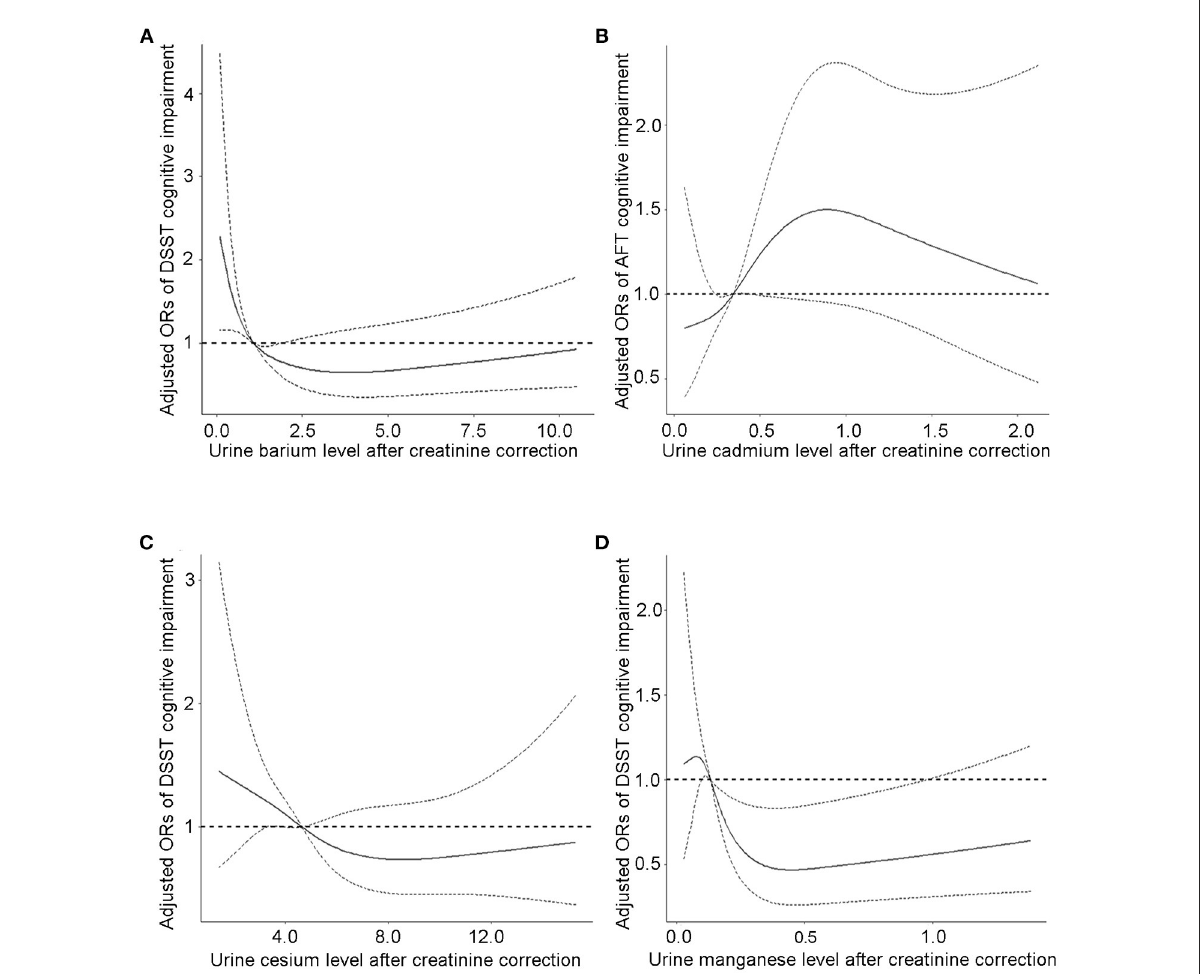
FIGURE2 The continuous relationship between urinary (A) barium levels, (C) cesium levels, (D) manganese levels and DSST cognitive test scores based on a restricted cubic spline regression model. The continuous relationship between (B) cadmium levels and AFT cognitive test scores based on a restricted cubic spline regression model. Adjusted for covariates (age, sex, educational level, BMI, and PIR). The solid lines represent the ORs, and dashed lines represent the 95%